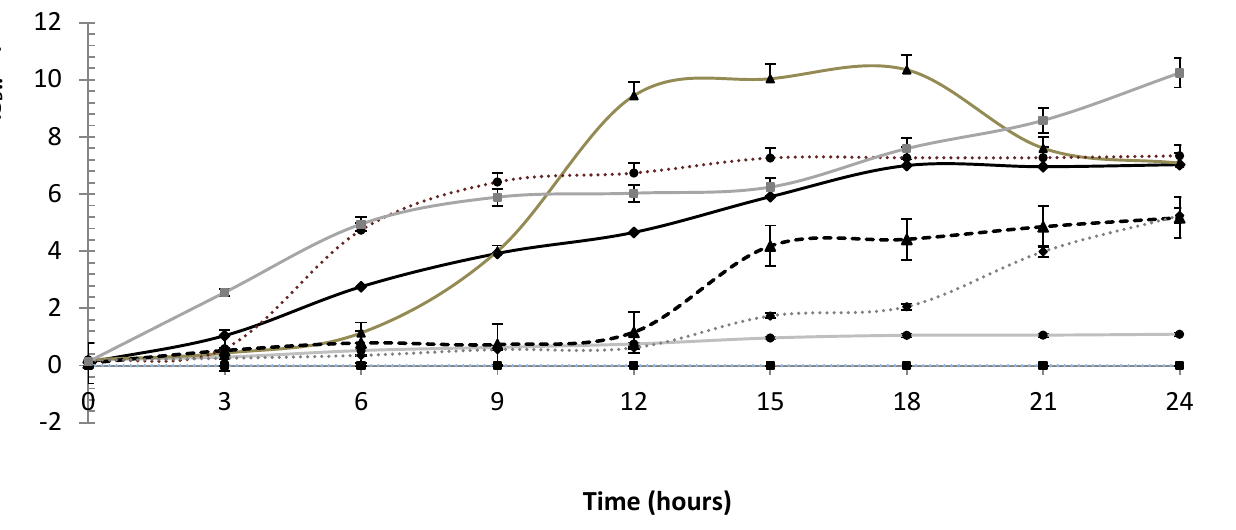
Figure 2. Growth of P. pentosaceus ATCC 43200 under different culture conditions. Runs: 1 ( ■ ); 2 ( ♦ ); 3 (●); 4 ( ▲ ); 5 (-- ▲ --); 6( …●… ); 7 ( … ♦ … ); 8 ( ■ ). For conditions of runs and controls see Table 1.